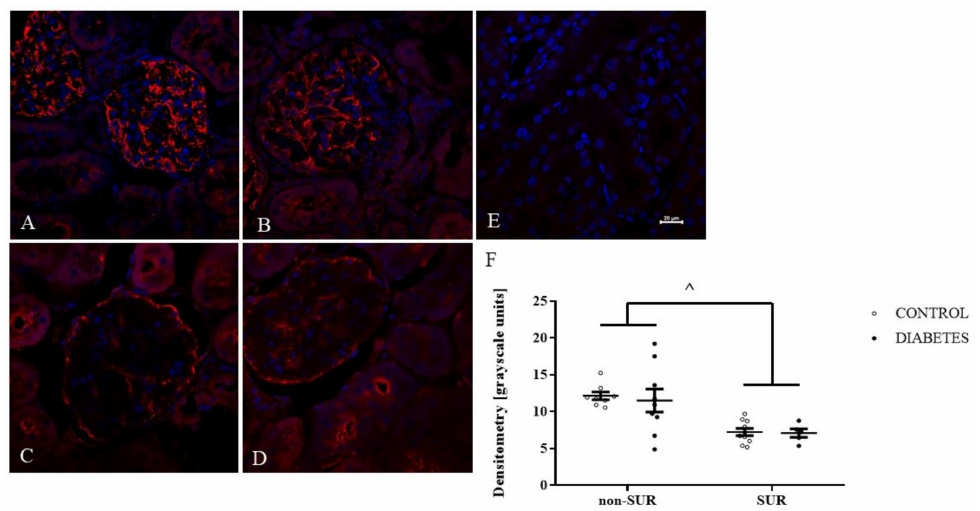
Figure 4. Immunofluorescent localisation and quantitative analysis of vascular endothelial growth factor A (VEGF-A) in glomeruli of non-diabetic and diabetic rats treated with suramin. Suramin (SUR, 10 mg/kg) or saline (non-SUR) were injected into non-diabetic rats (CONTROL) and streptozotocin- induced diabetic rats (DIABETES) on days 0 and +7 after streptozotocin or citrate buffer injection on day –7. Glomerular immunofluorescence staining of VEGF-A (red) and counterstained cell nu- clei with DAPI (blue) were analysed by confocal microscopy: ( A ) non-diabetic suramin-untreated; ( B ) diabetic suramin-untreated; ( C ) non-diabetic suramin-treated; ( D ) diabetic suramin-treated; ( E ) kidney sections incubated only with the secondary antibodies (negative control); the bar corre- sponds to 20 µ m; ( F ) quantitative analysis of the VEGF-A fluorescent signal in glomeruli. The mean fluorescence signal associated with VEGF-A in each glomeruli section was measured by ImageJ analysis and quantified manually as a mean grey value; the intensities (mean ± standard deviation) are plotted in arbitrary units (a.u). Statistical significance ˆ p < 0.0001 (two-way ANOVA, Tukey for unequal sample sizes and Bonferroni post-hoc